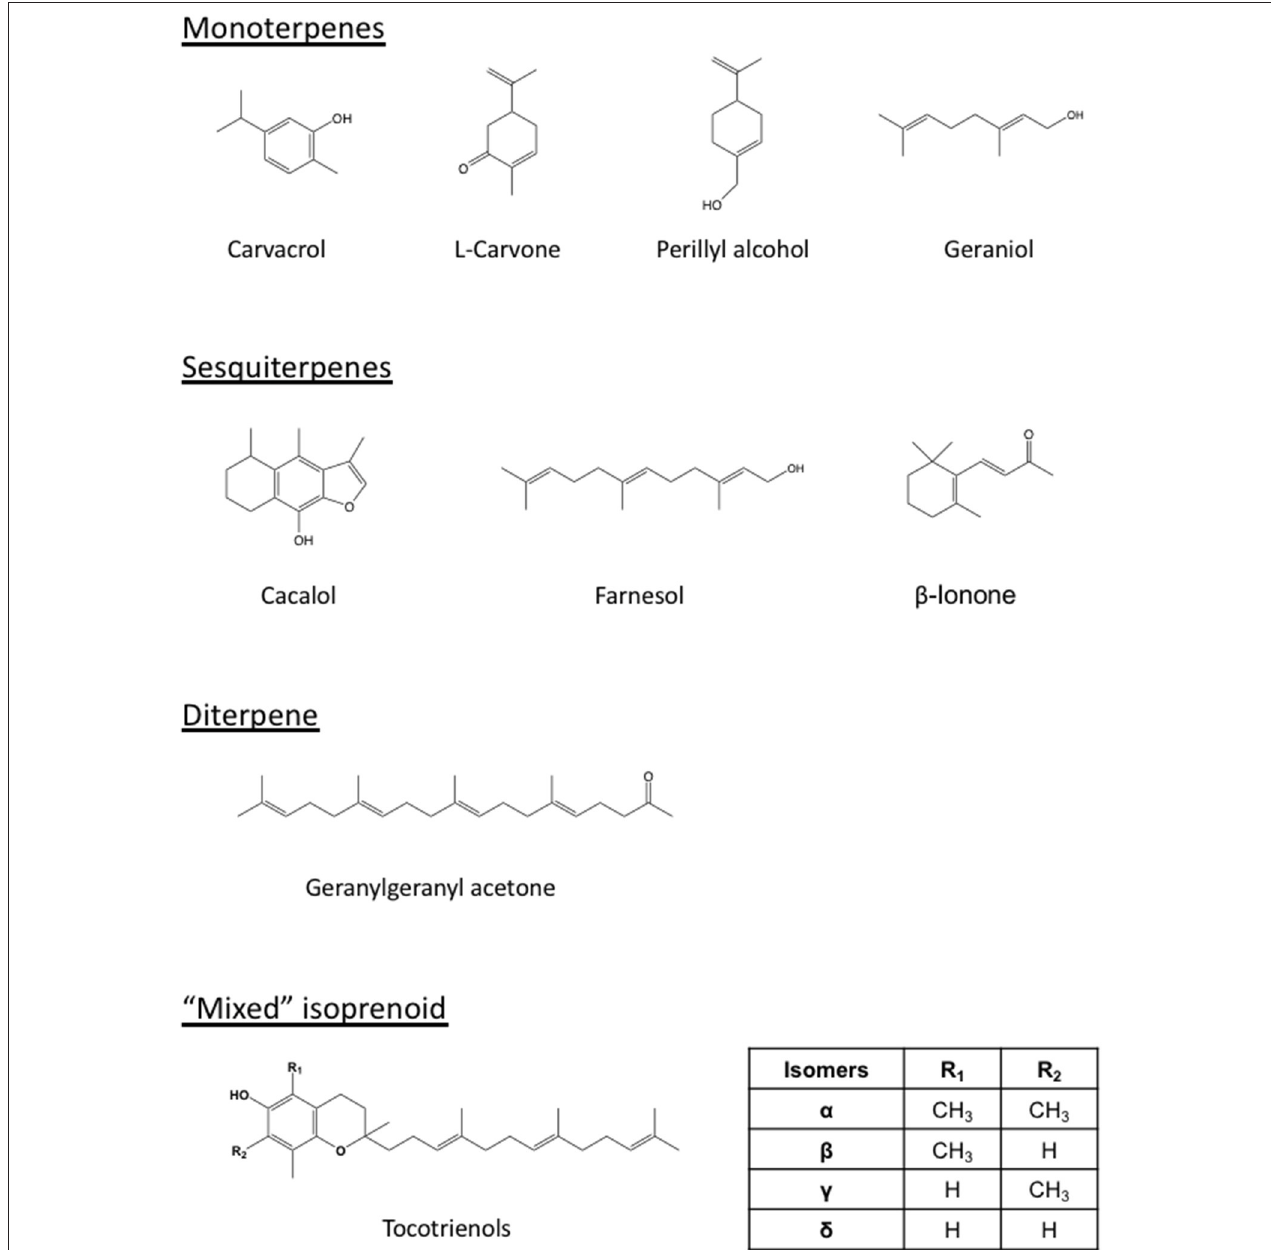
FIGURE 2 | Structures of representative isoprenoids that impact tumors or potentiate the statin-mediated tumor suppression. Differing from the monoterpenes (carvacrol, carvone, perillyl alcohol, geraniol), sesquiterpenes (cacalol, farnesol, β -ionone), and diterpene (geranylgeranyl acetone), the tocotrienols are “mixed” isoprenoids with only part of their structure derived from the mevalonate pathway. The number and location of methyl group (R 1 and R 2 ) on the chromanol ring vary among the members ( α , β , γ , and δ ) of